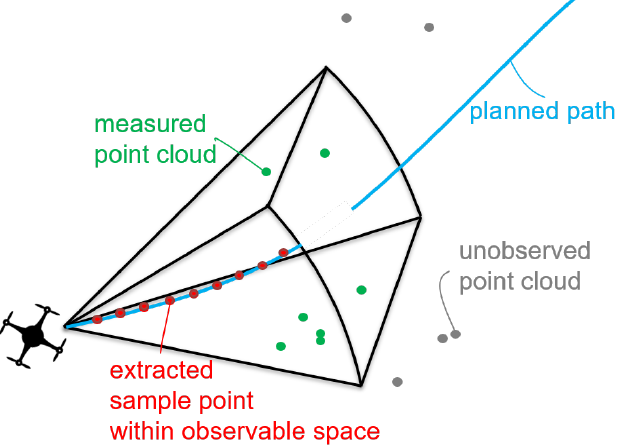
Figure 2. Sensor’s range and field-of-view (FOV) on the measured point cloud and the extracted sample